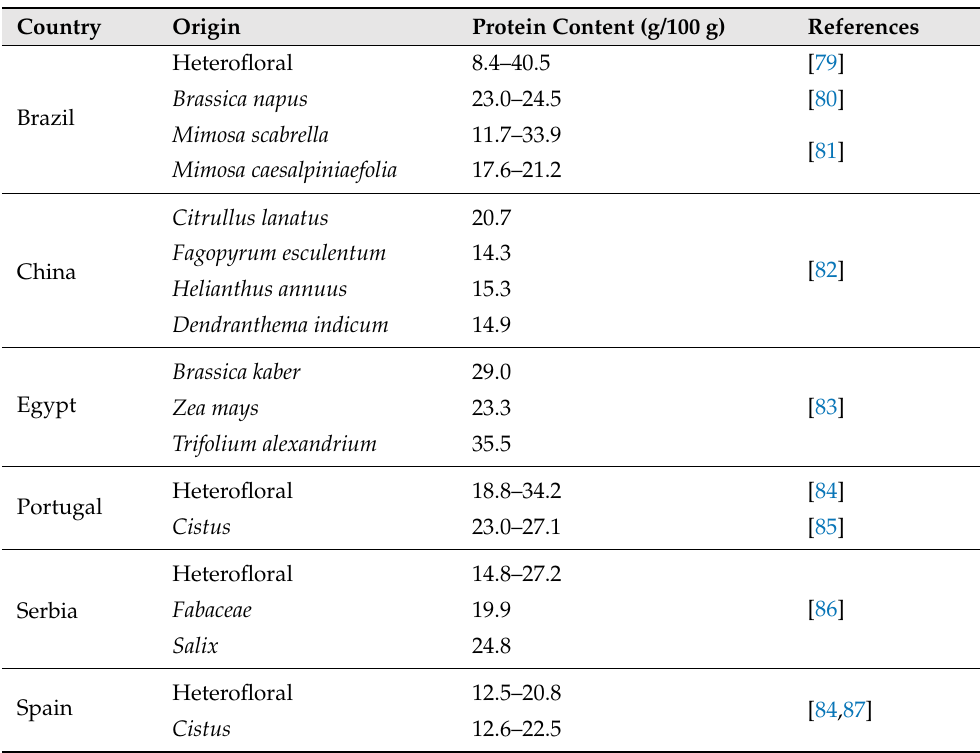
Table 2. Protein content of bee pollen originating from different Table 2 . Protein content of bee pollen originating from different countries.